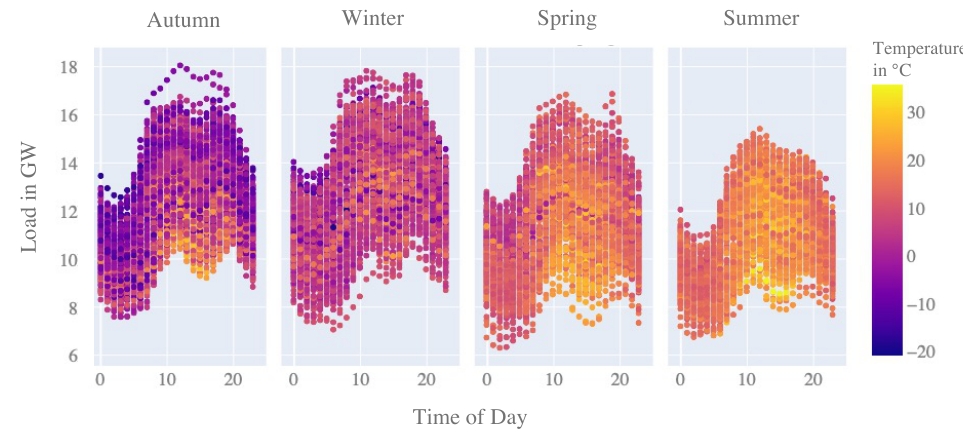
Figure 4. Figures of generation, load, and import-exports in 50 HzT Zone (Year 2019). Data source: Entsoe Transparency Platform [32].